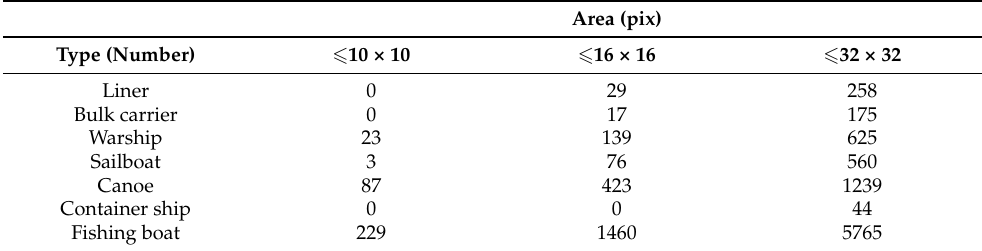
Table 2. The distribution of small targets in the infrared ocean